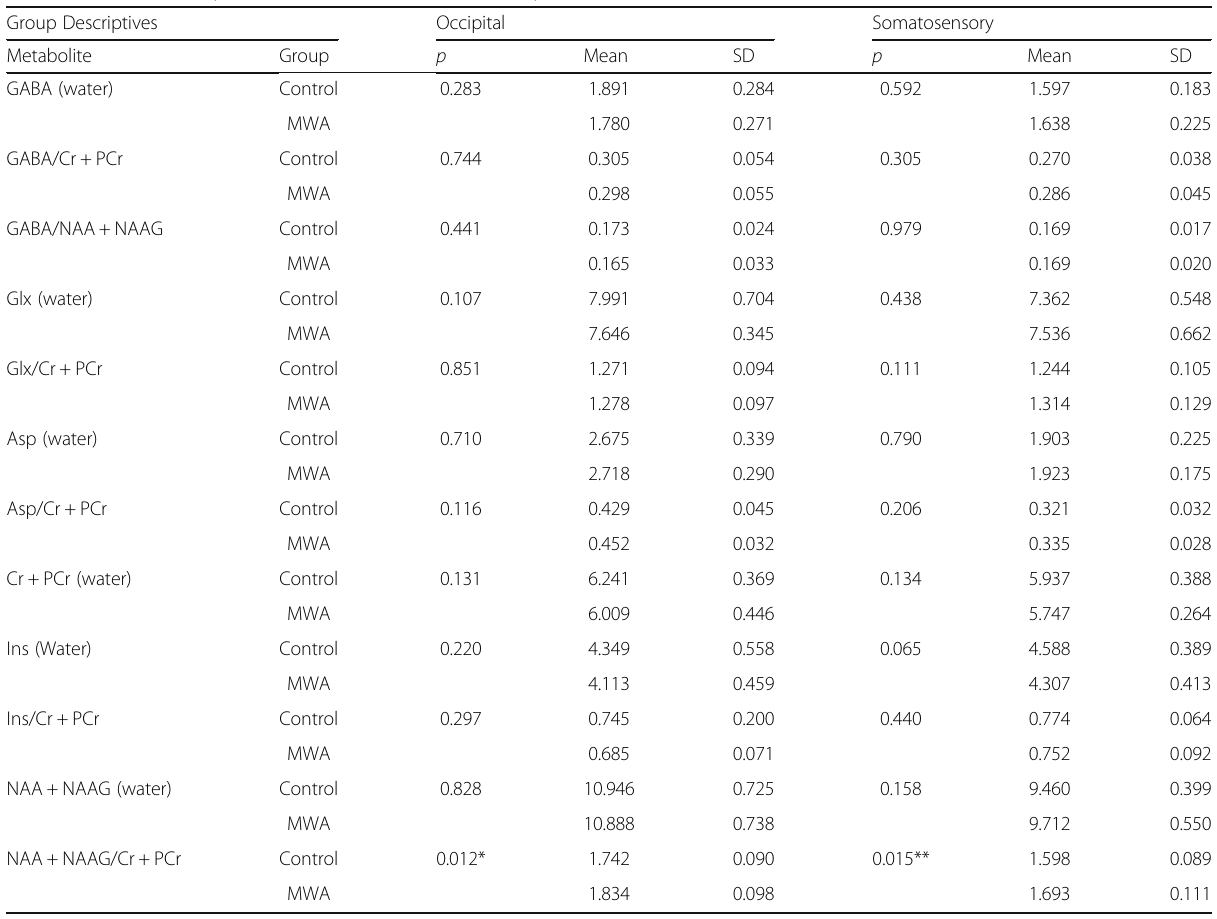
Table 3 All values are presented as mean ratios, Two-sample t-tests Group